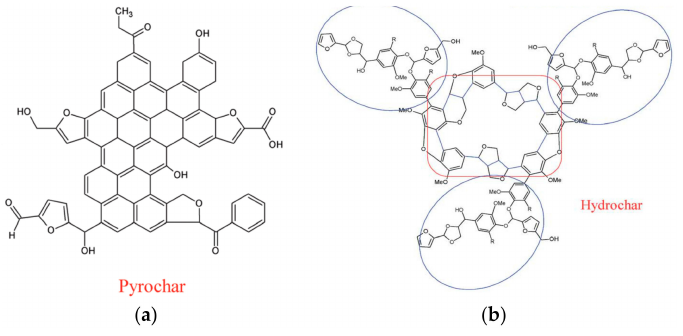
Figure 7. Chemical structures of pyrochar and hydrochar: ( a ) chemical structure of pyrochar; ( b ) chemical structure of hydrochar. Reprinted from Reference [13] published by The Royal Society of